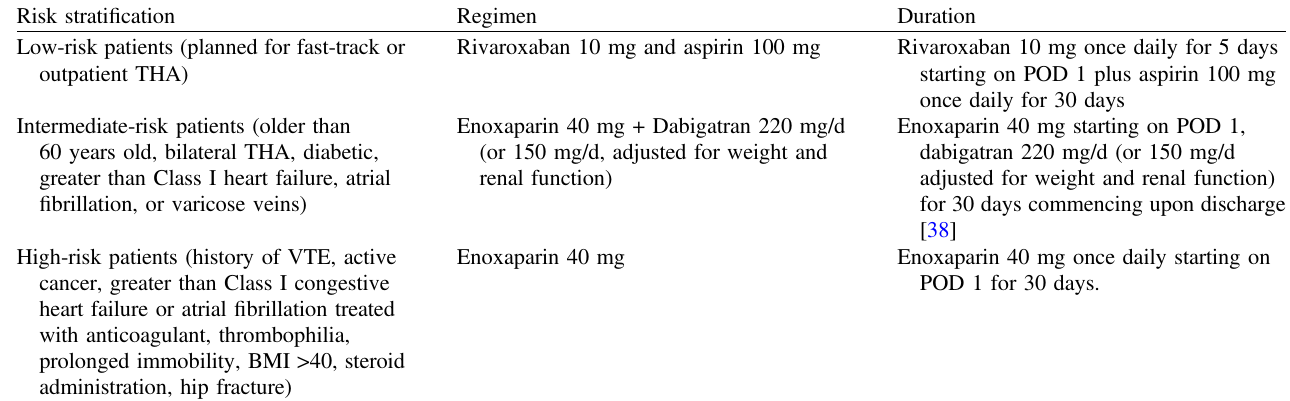
Table 1. Institutional protocol for VTE prophylaxis in patients undergoing THA based on risk strati fi cation. Risk strati fi cation